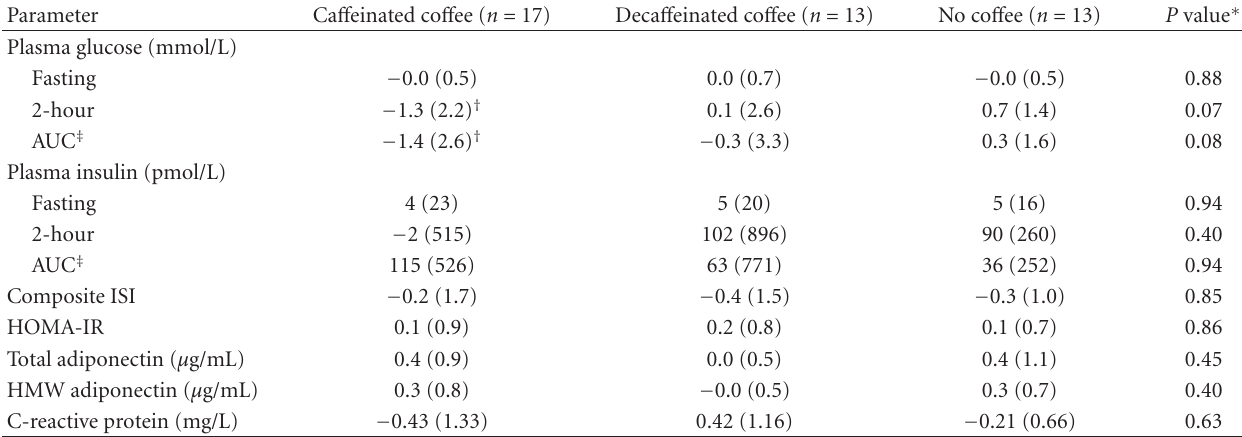
Table 3: Mean changes of glucose metabolism parameters and serum adiponectin and C-reactive protein at 16 weeks of intervention as compared with the baseline